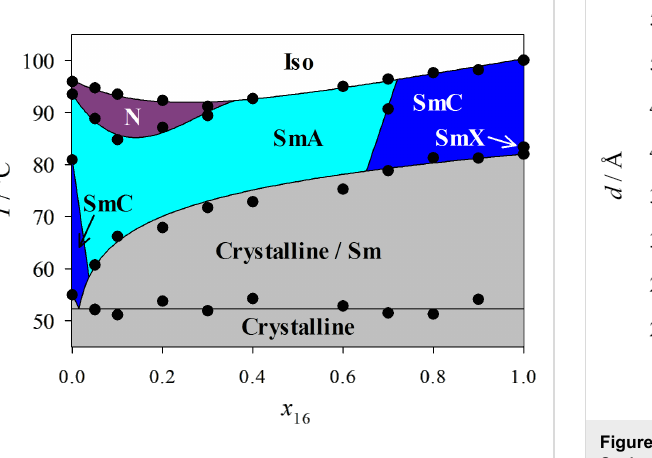
Figure 3: The phase diagram of the binary mixture system PhP16 / 2PhP .